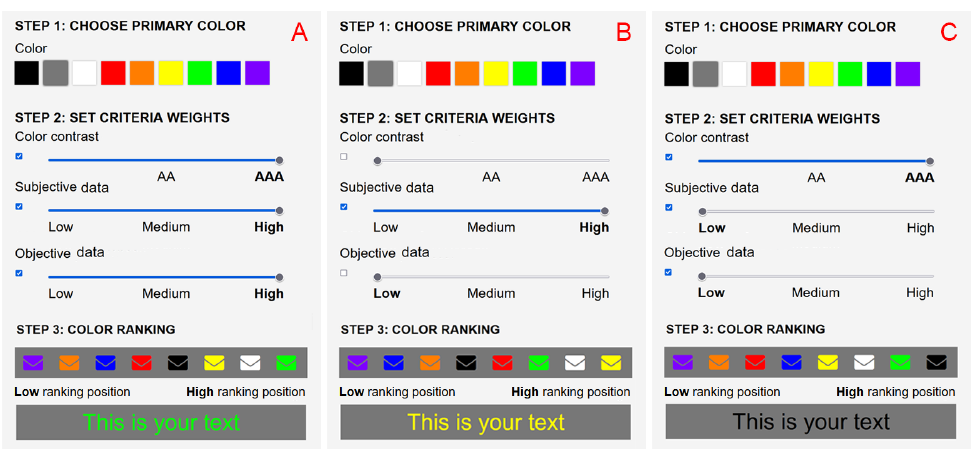
Figure 9. The research results were made available with the ColoUR Balance